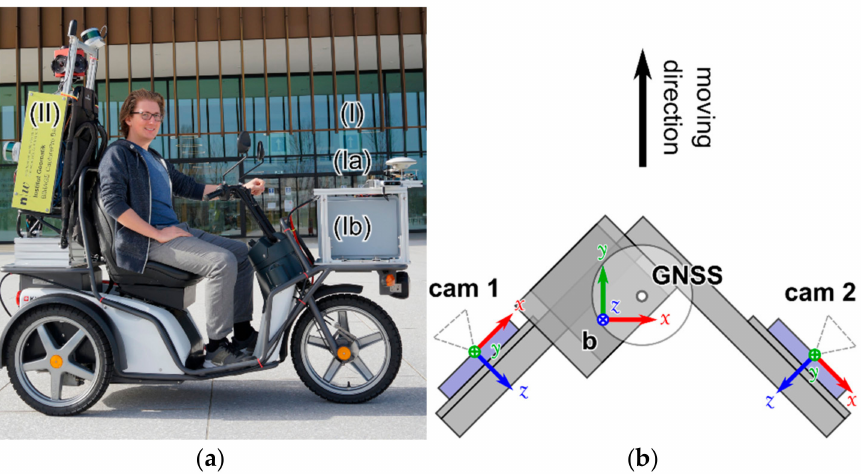
Figure 1. Overview of the workflow for acquiring, processing, and analyzing RGB-D imagery to detect parked vehicles and generate on-street parking statistics.